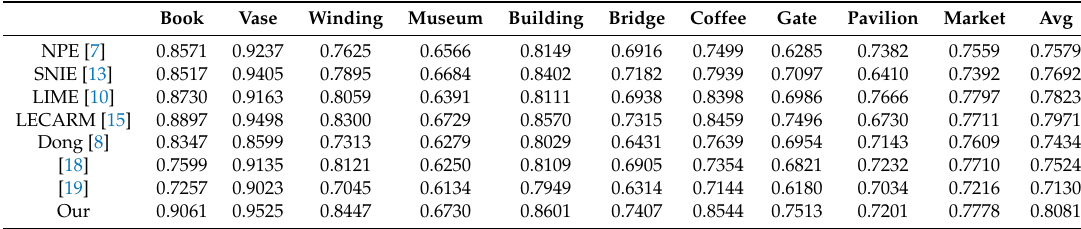
Table 2. MEF-SSIM of eight different